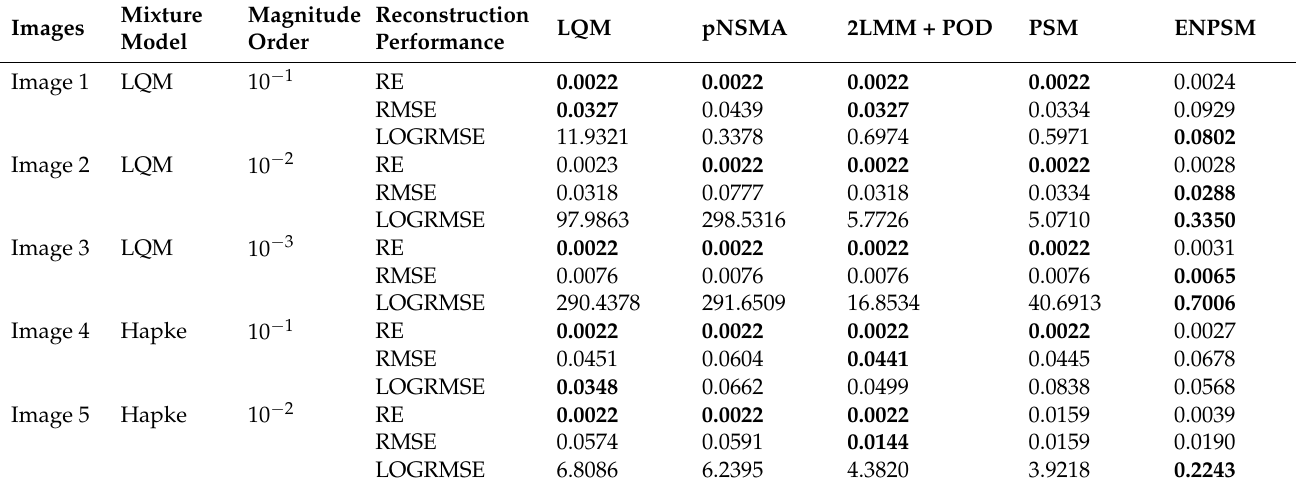
Table 2. Reconstruction performances: RE, RMSE, and LOGRMSE results produced by LQM, pNSMA, p LMM, PSM, and ENPSM over synthetic images generated based on Hapke’s equations and LQM using endmembers of oil and seawater. The best results are highlighted in